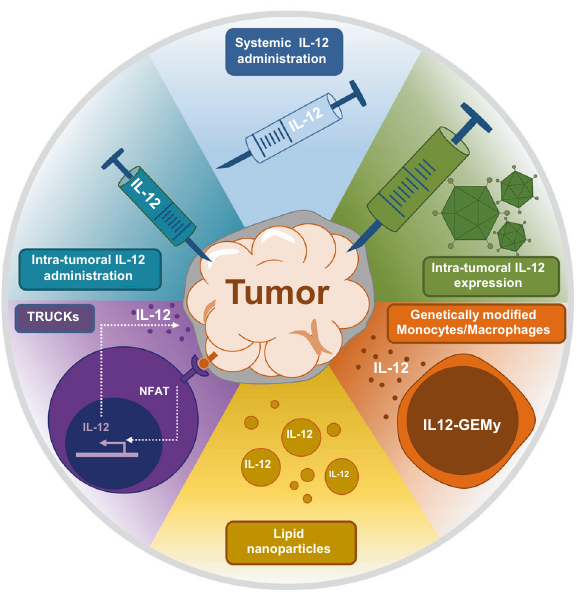
Fig. 1 Strategies to deliver cytokines to improve anticancer therapies. Cytokines (e.g., IL-12) that can recruit immune cells to the tumor or pre-metastatic sites continue to be tested in therapeutic oncology settings. Several methods to apply IL-12 are shown here, including the use of lipid nanoparticles, “ T cells redirected for universal cytokine-mediated killing ” (TRUCKs), intra- tumoral administration, systemic application, intratumoral expres- sion, and genetically engineered myeloid cells